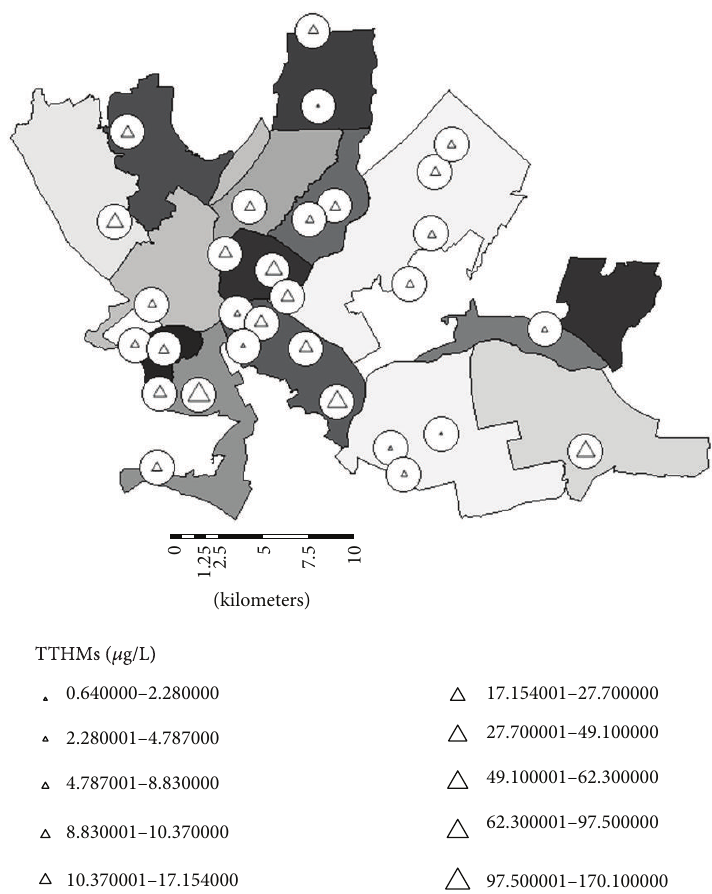
F 2: Spatial analysis of TTHM concentration.